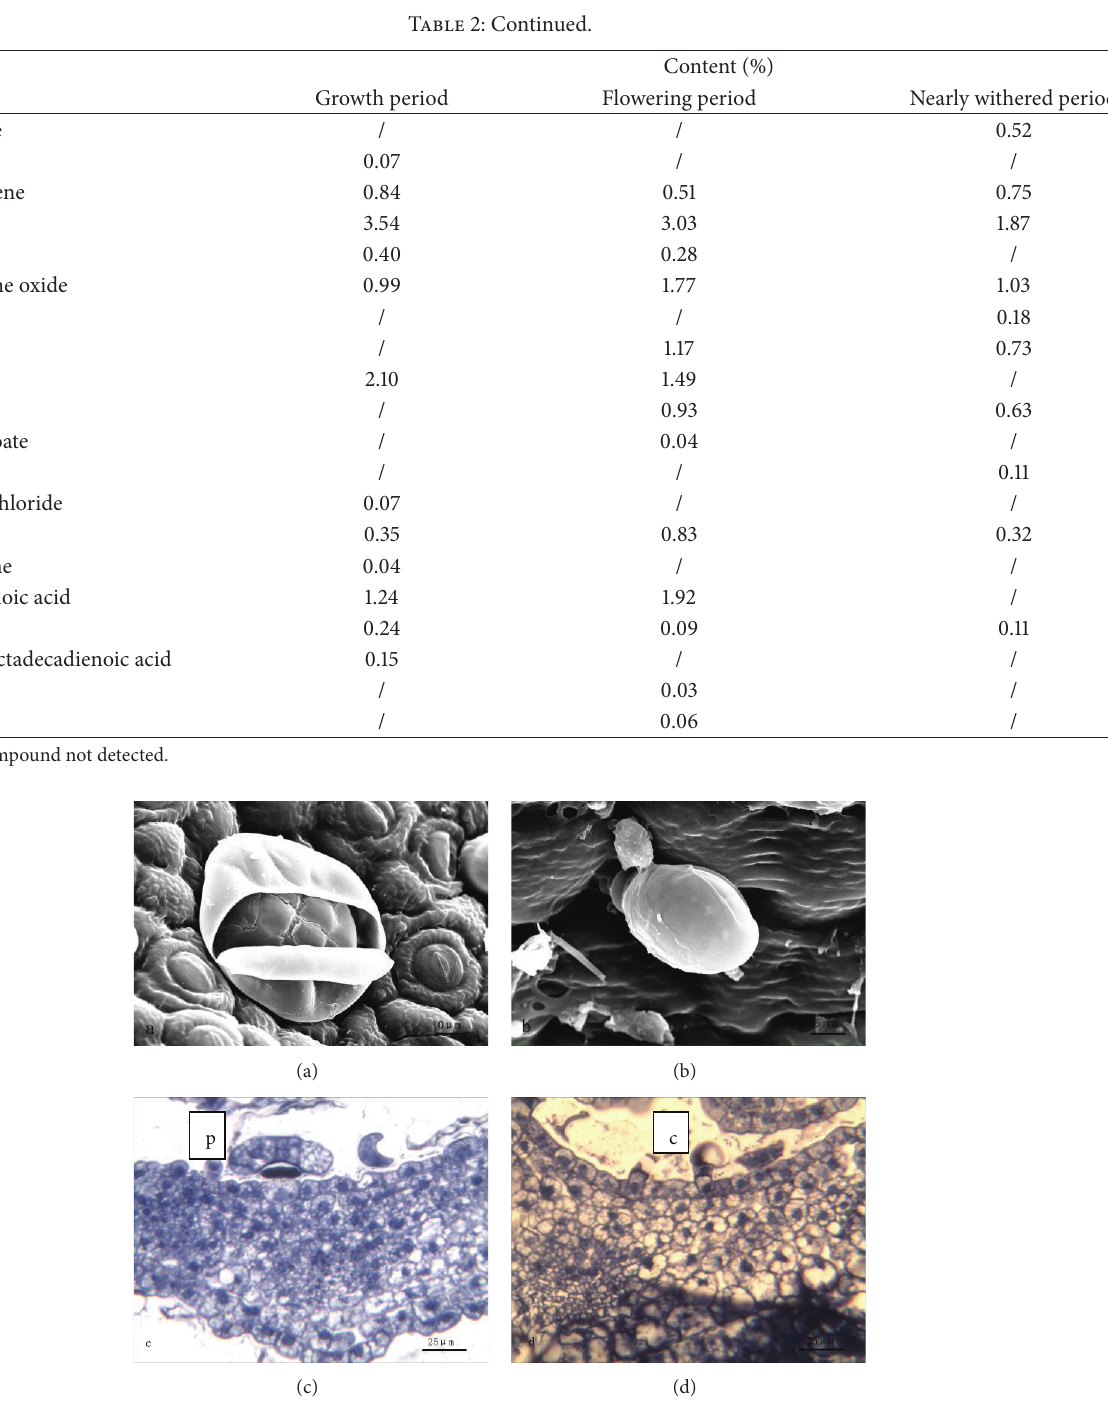
Figure1:((a),(b))SEMmicrographsshowingthemorphologyofglandulartrichomesontheleafof T. quinquecostatus. (a)Apeltatetrichome. (b) A capitate trichome. ((c), (d)) Transverse sections of T. quinquecostatus leaf. (c) A peltate trichome (p). (d) A capitate trichome